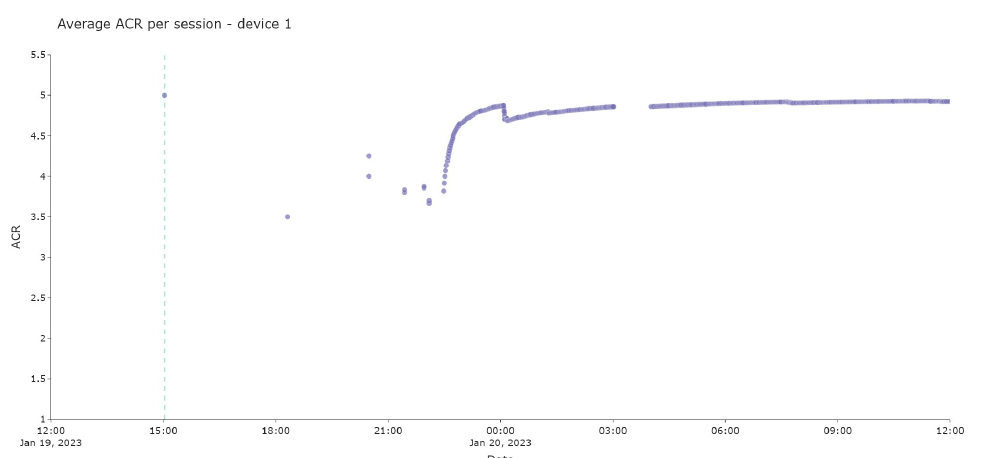
Figure 14. Average ACR grade for entire viewing session for first device.